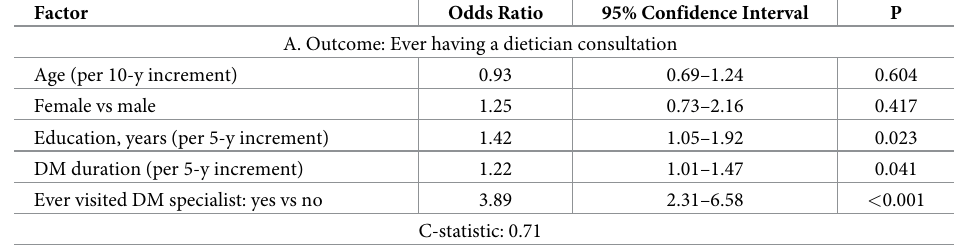
Table 2. Multivariable logistic regression models of factors associated with a) ever having a dietician consultation; b) meeting the leisure physical activity recommendation; c) reporting economic barriers to any aspect of diabetes man- agement; and, d) moderate-to-severe depression symptoms among DAPI survey respondents (n = 296).